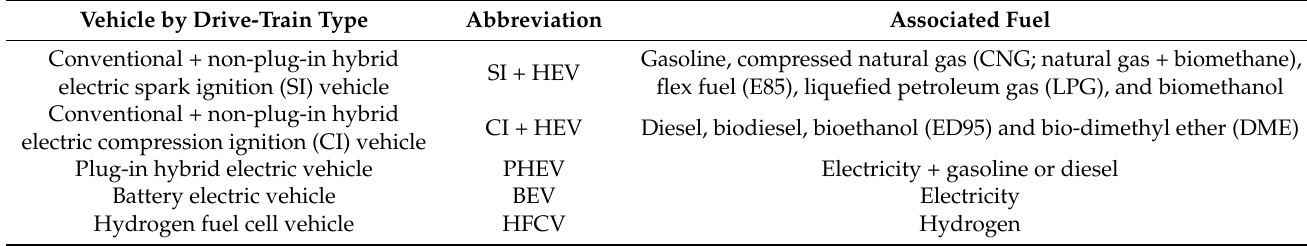
Table 4. Types of road vehicle by drive-train technology and associated fuel.